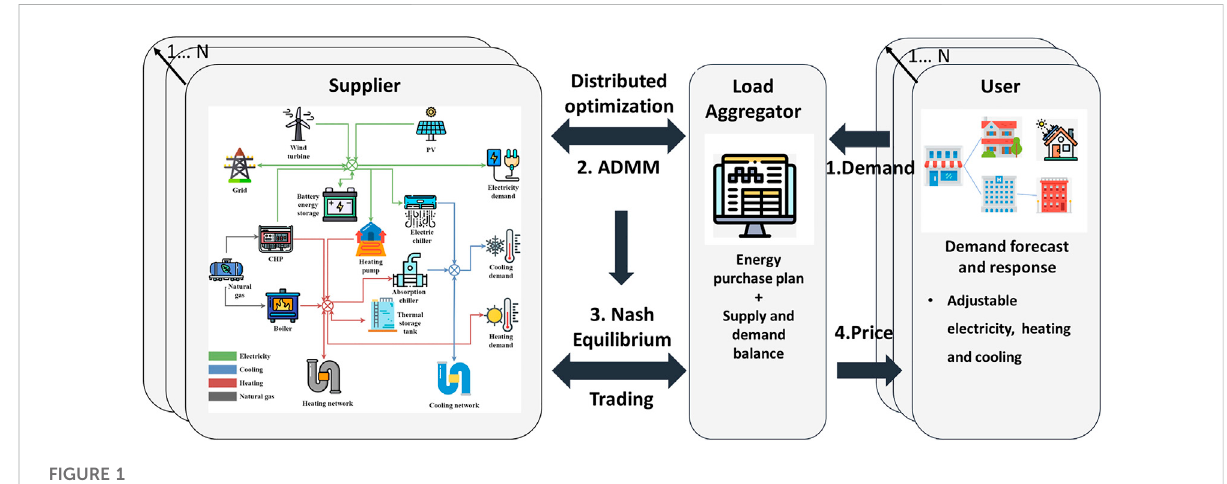
FIGURE 1 Schematic diagram of the holistic